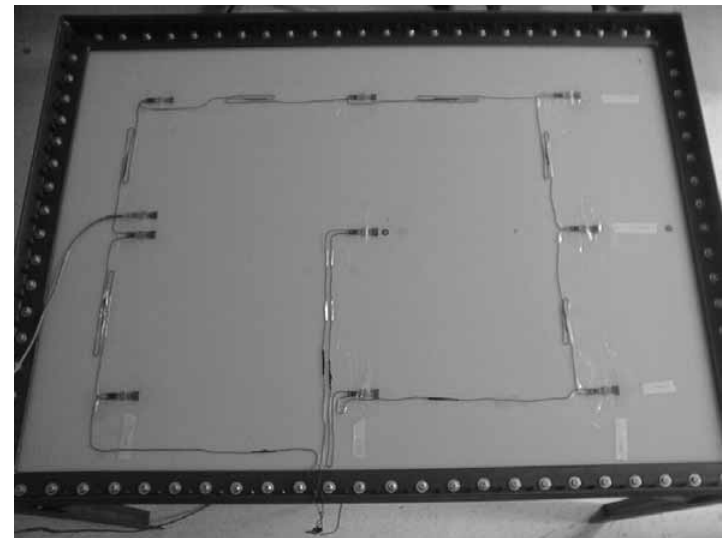
Fig. 14. Fiberglass panel with a Continuous Sensor.